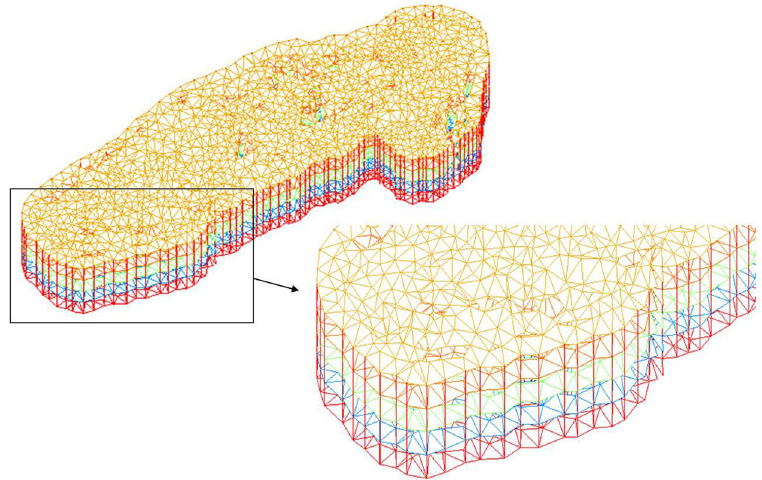
Figure 3. Finite element space grid setting.